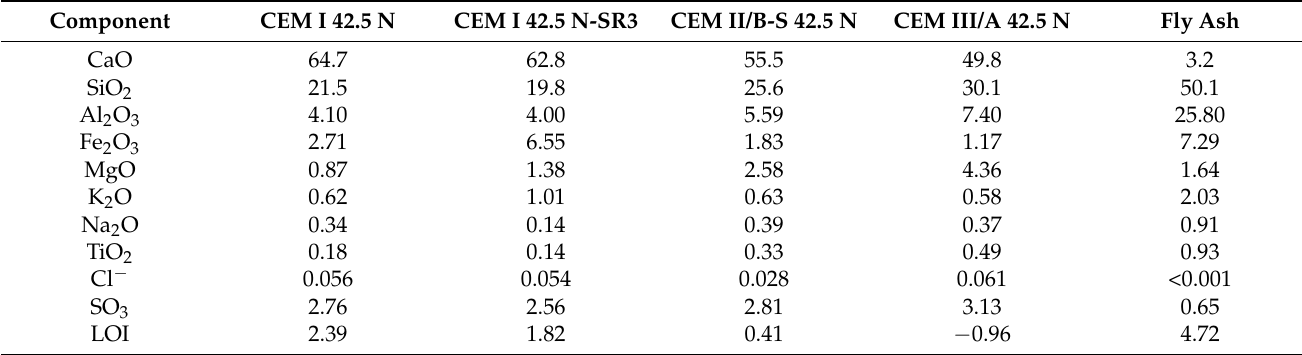
Table 1. Chemical composition of the cements and the fly